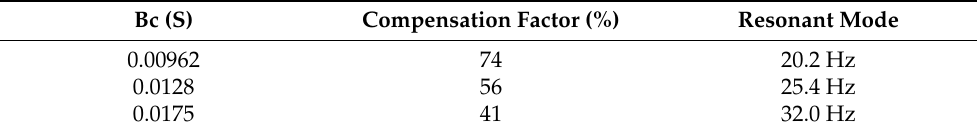
Table 3. Compensation